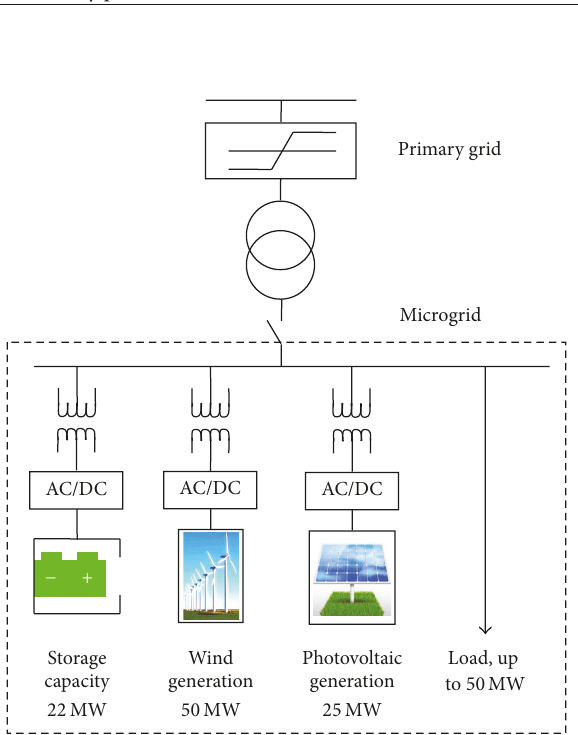
Figure 3: Constitution of microgrid of Suzhou Industrial Park.